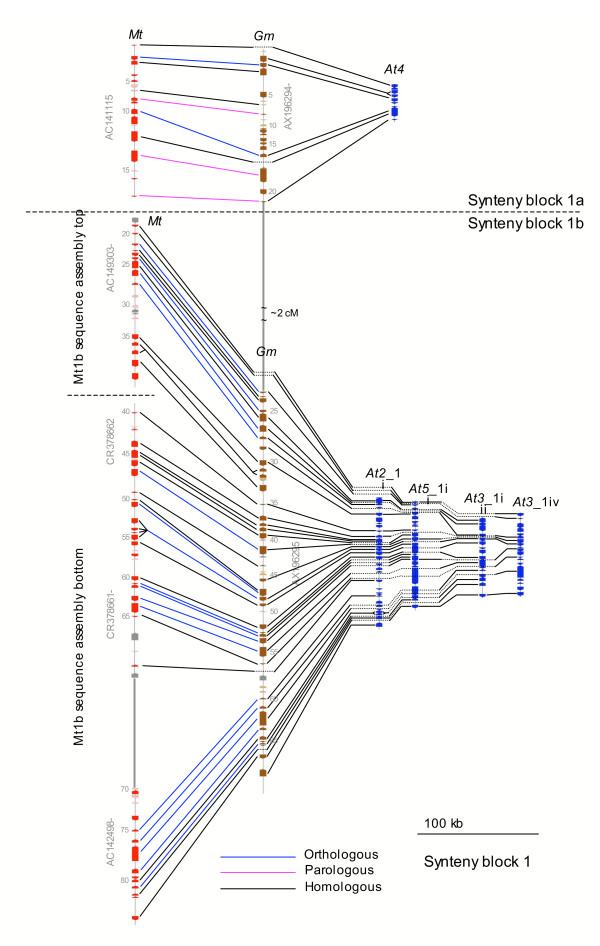
Synteny block 1. A syntenic block of soybean, M. truncatula and A. thaliana genes surrounding soybean's rhg1 gene (Gm gene 21). Solid black lines connect homologs. Dotted black lines indicate that the absence of a homolog in the syntenic position. Blue lines connect orthologs. Pink lines connect paralogs. M. truncatula genes are shown in red, soybean in brown, and A. thaliana in blue. Lighter colored genes represent those that had no significant similarity to Genbank's nonredundant protein database. Gray genes are repetitive elements. A thick gray vertical line connecting sequence assemblies indicate regions in which sequence is not yet available but in which linkage and approximate distance were determined. Genbank accessions are shown in gray.